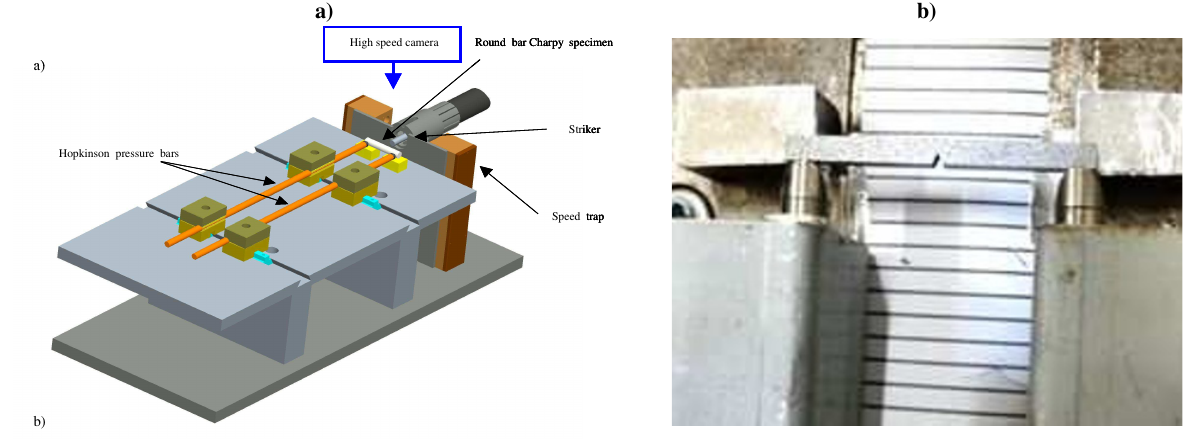
Fig. 2. Charpy like experiment : (a) schematic, (b) sample in position prior